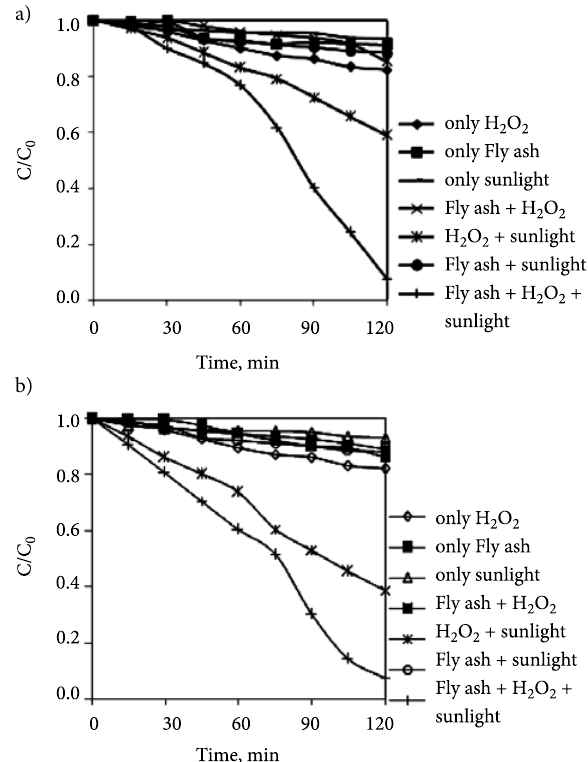
Fig. 7. Preliminary experiments performed under different conditions to evaluate their efficiency towards a)